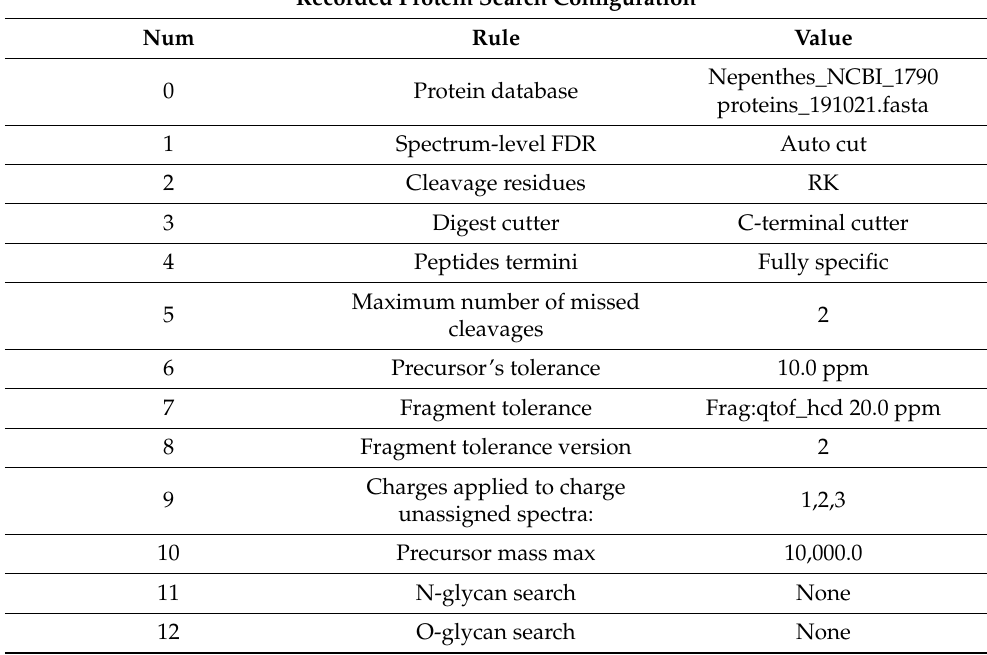
Table A2. Byonic TM search